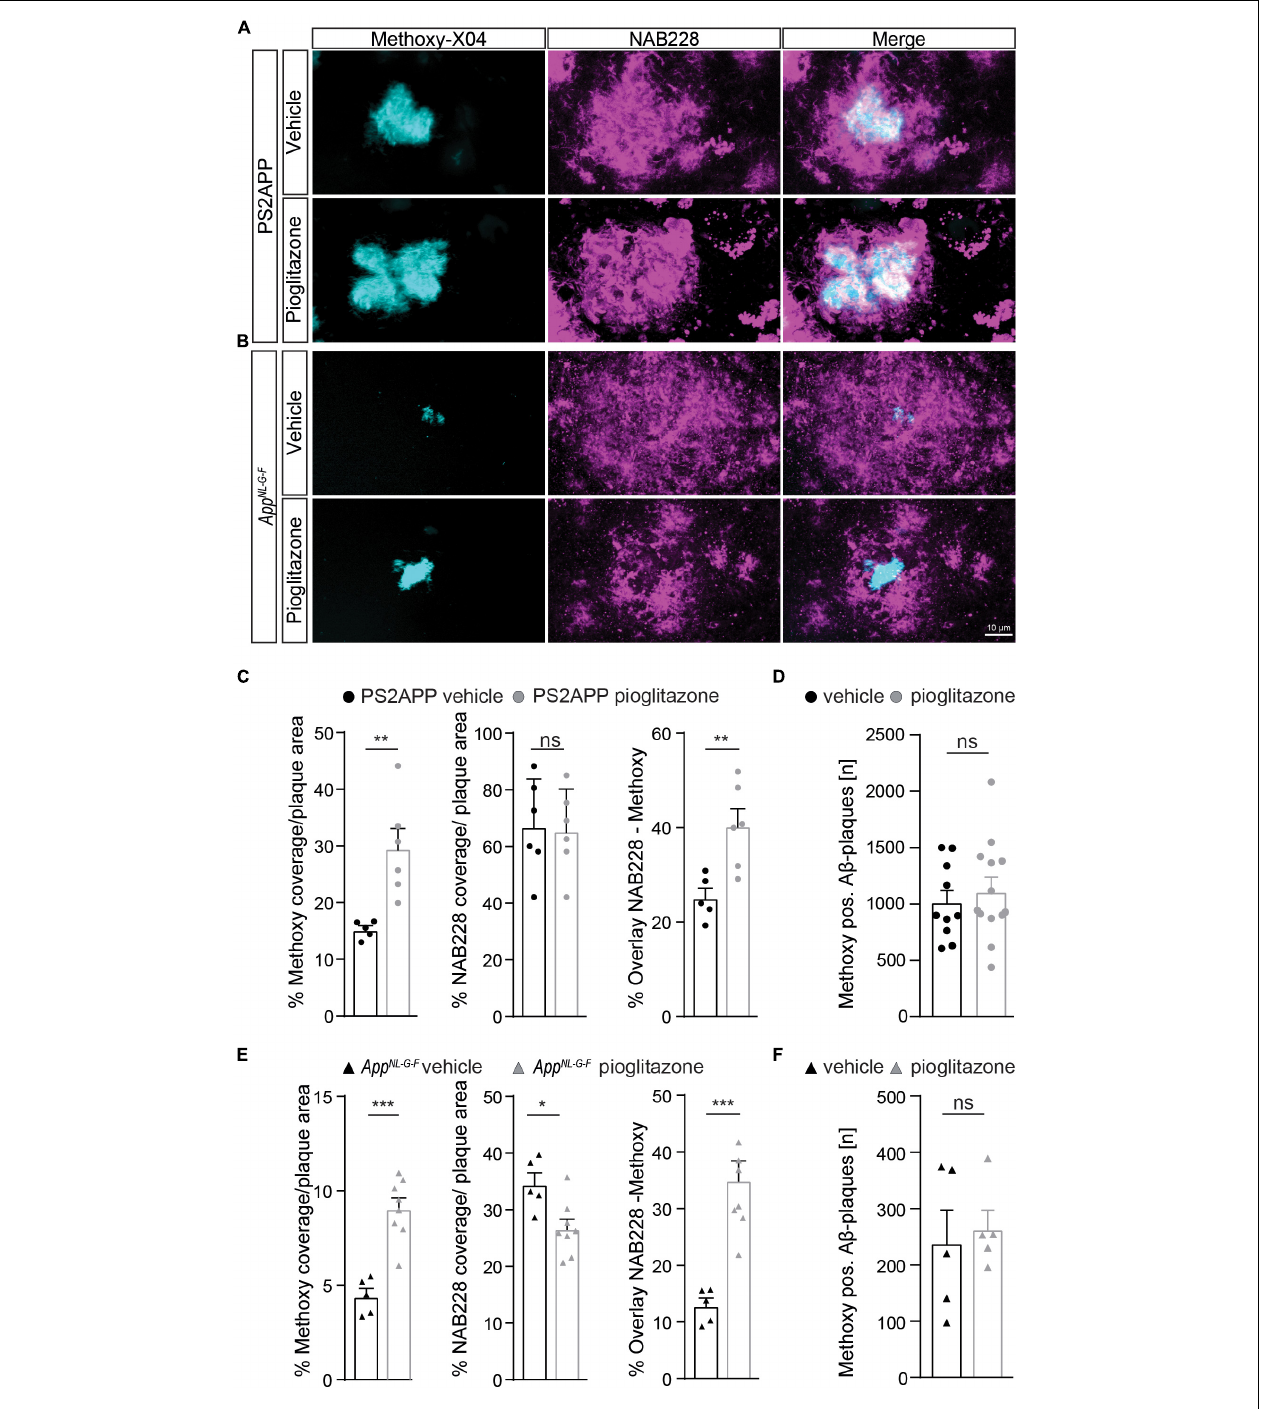
FIGURE 3 | Pioglitazone treatment triggers a change in plaque composition in two different mouse models of amyloidosis. Staining of fibrillary A β (methoxy-X04, cyan) and pre-fibrillary A β (NAB228, magenta) in vehicle and pioglitazone treated PS2APP mice (A) and App NL - G - F mice (B) . (C) The plaque area covered by methoxy-X04 staining was significantly higher [ t ( 9 ) = 3.612; p = 0.0056], whereas the plaque area covered by NAB228 staining remained equal [ t ( 10 ) = 0.175; p = 0.865] in pioglitazone treated PS2APP mice. The overlay of NAB228 and methoxy staining increased under pioglitazone treatment [ t ( 9 ) = 3.432; p = 0.0075]. (D) The number of methoxy positive A β -plaques did not change under pioglitazone treatment in PS2APP-mice. (E) In App NL - G - F mice, methoxy coverage [ t ( 11 ) = 5.802; p = 0.0001], NAB228 coverage [ t ( 11 ) = 5.80; p = 0.0001], as well as the overlay of both staining [ t ( 11 ) = 2.93; p = 0.0138], increased under pioglitazone treatment. (F) In App NL - G - F mice, the number of methoxy positive A β -plaques did not change under pioglitazone. Data are presented as mean ± SEM; n = 5–13 mice. Two-sample student’s t -test results: * p < 0.05; ** p < 0.01; *** p < 0.001.